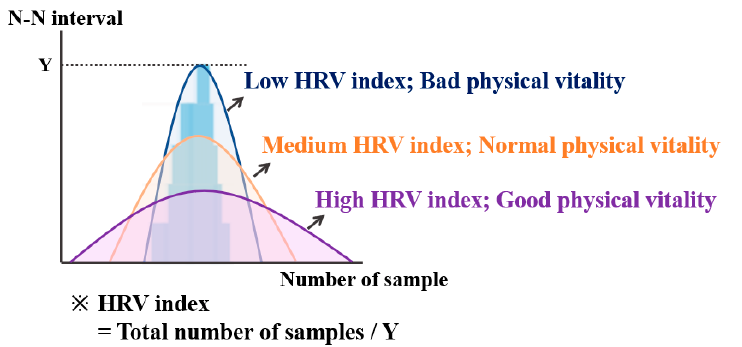
Figure 2. HRV-index and physical vitality evaluation with the probability distribution of HRV.